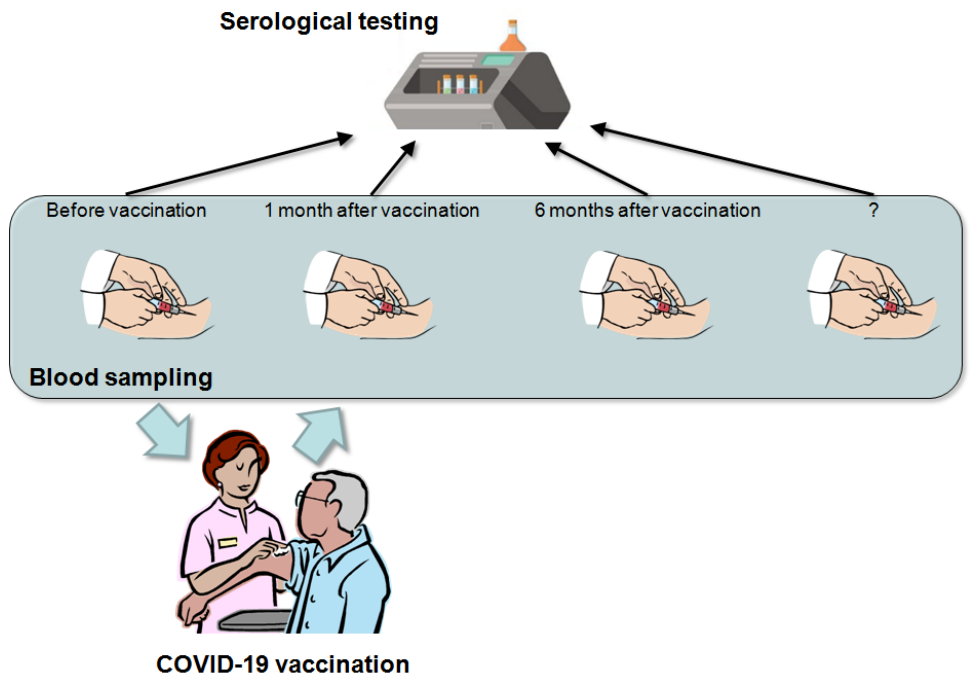
Figure 1. Suggested time points for anti-SARS-CoV-2 antibodies’ titration in recipients of COVID-19 vaccinations, encompassing a baseline assessment, followed by antibody level monitoring at least 1 and 6 months after the last vaccine dose.